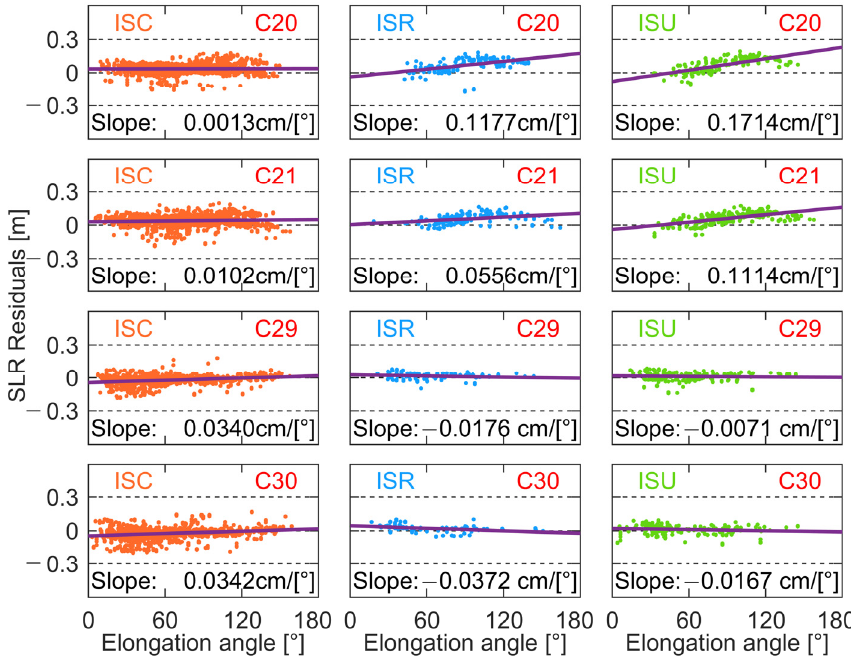
Figure 20. SLR residuals of BDS-3 satellites based on three types of iGMAS B1C/B2a orbits versus elongation angle.